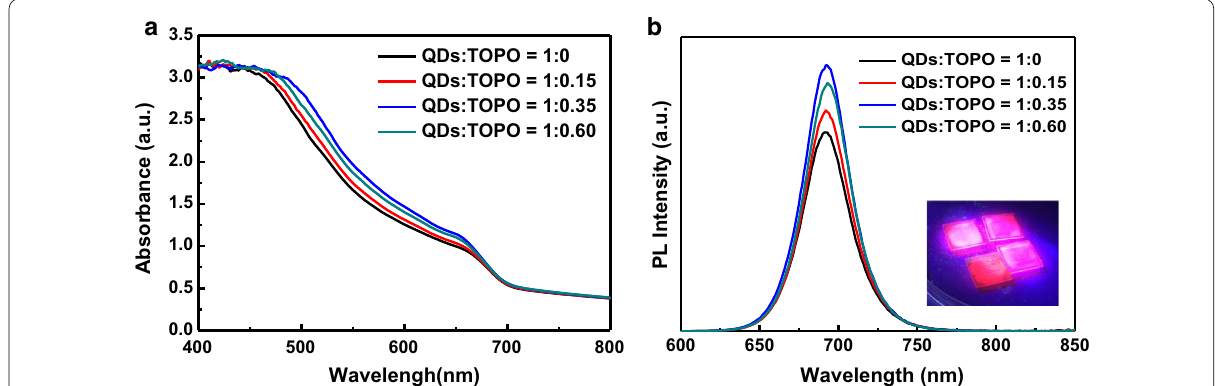
Fig. 6 a Ultraviolet–visible (UV–Vis) absorption spectra, b photoluminescence (PL) spectra of CsPbI 3 /TOPO composite films with different ratios; the inset is the fluorescence photograph of the CsPbI 3 /TOPO composites/glass under 365 nm light excitation